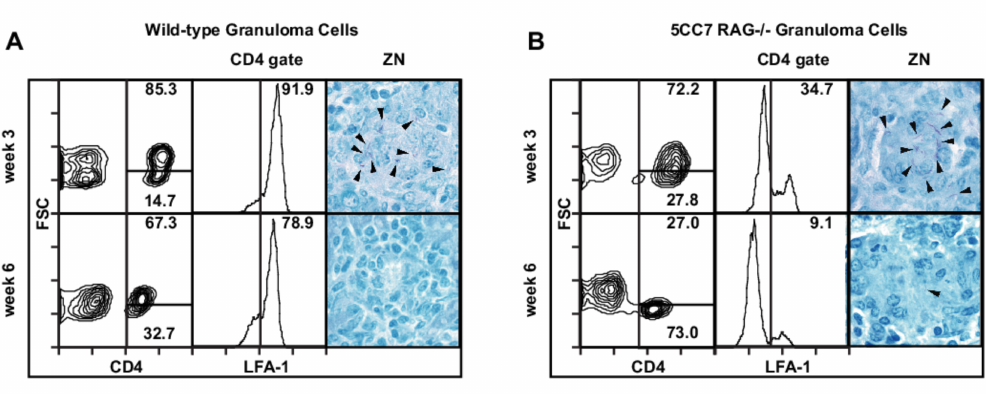
Figure 1. Wild-type mice and 5CC7 RAG − / − mice both form protective granulomas after PCC-BCG infection but 5CC7 T cells show lower levels of activation. ( A ), Wild-type mice were infected intraperitoneally (i.p.) with BCG and stained for CD4 and LFA-1 at three and six weeks post-infection. Numbers in left panels represent percentage of CD4 + that are large (blasting). Middle panel is gated on CD4 + T cells as shown in the left panel and numbers represent the percent of CD4 + T cells that are LFA-1 high . The right panel shows Ziehl–Neelsen staining for acid-fast bacilli (AFB) indicated by arrowheads. ( B ), 5CC7 RAG − / − mice were infected i.p. with PCC-BCG and stained for CD4 and LFA-1 at three and six weeks postinfection. Numbers in leftmost panels represent percentage of CD4 + that are large/blasting. Second panel from left is gated on CD4 + T cells as shown in the leftmost panel and numbers represent the percent of CD4 + T cells that are LFA-1 high . Rightmost panel shows Ziehl–Neelsen staining for acid-fast bacilli (AFB) indicated by arrowheads. Figure representative of three independent experiments with 3 mice per